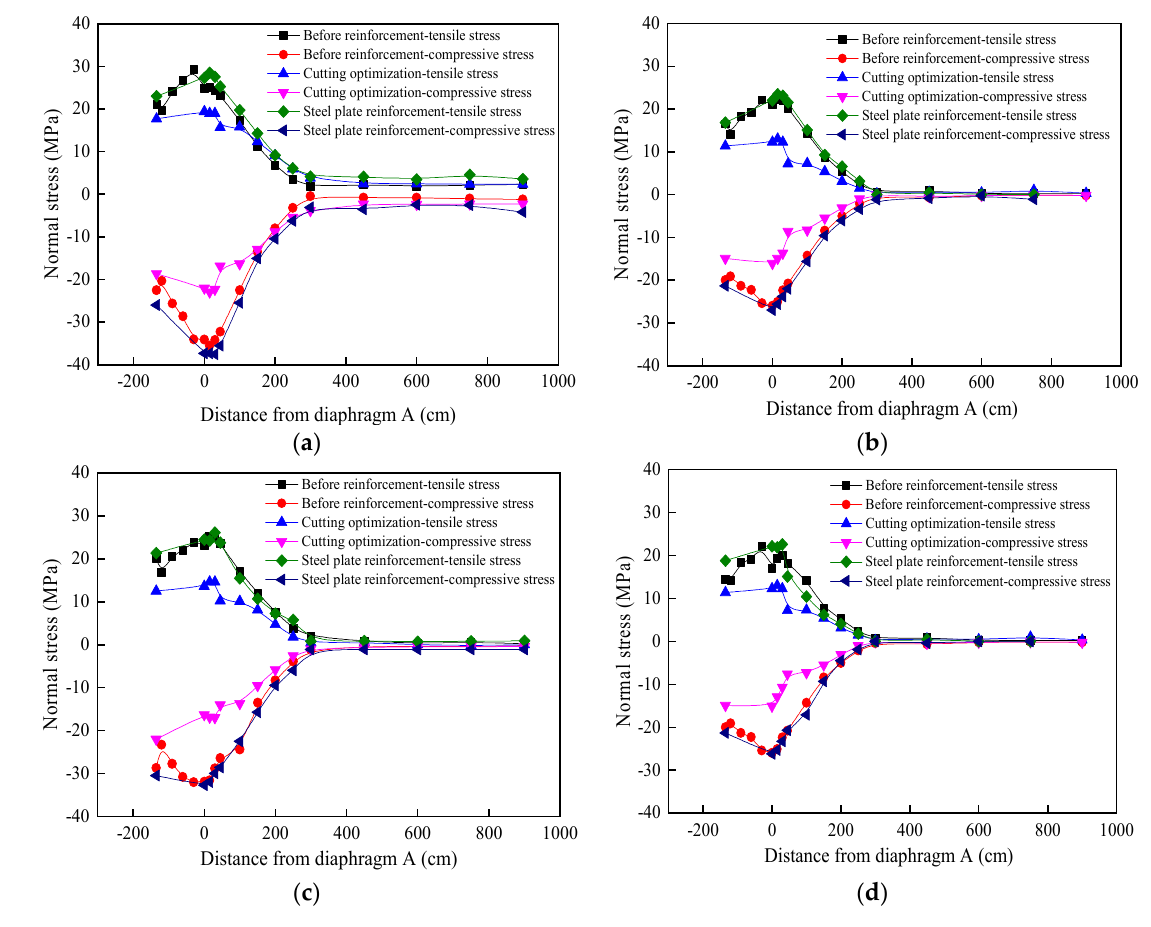
Figure 19. The relationship curve of stress-longitudinal load position at the measuring point of the oblique weld between parallel U-rib and transverse diaphragm: ( a ) E# measuring point, ( b ) F# measuring point, ( c ) e# measuring point, ( d ) f# measuring point.